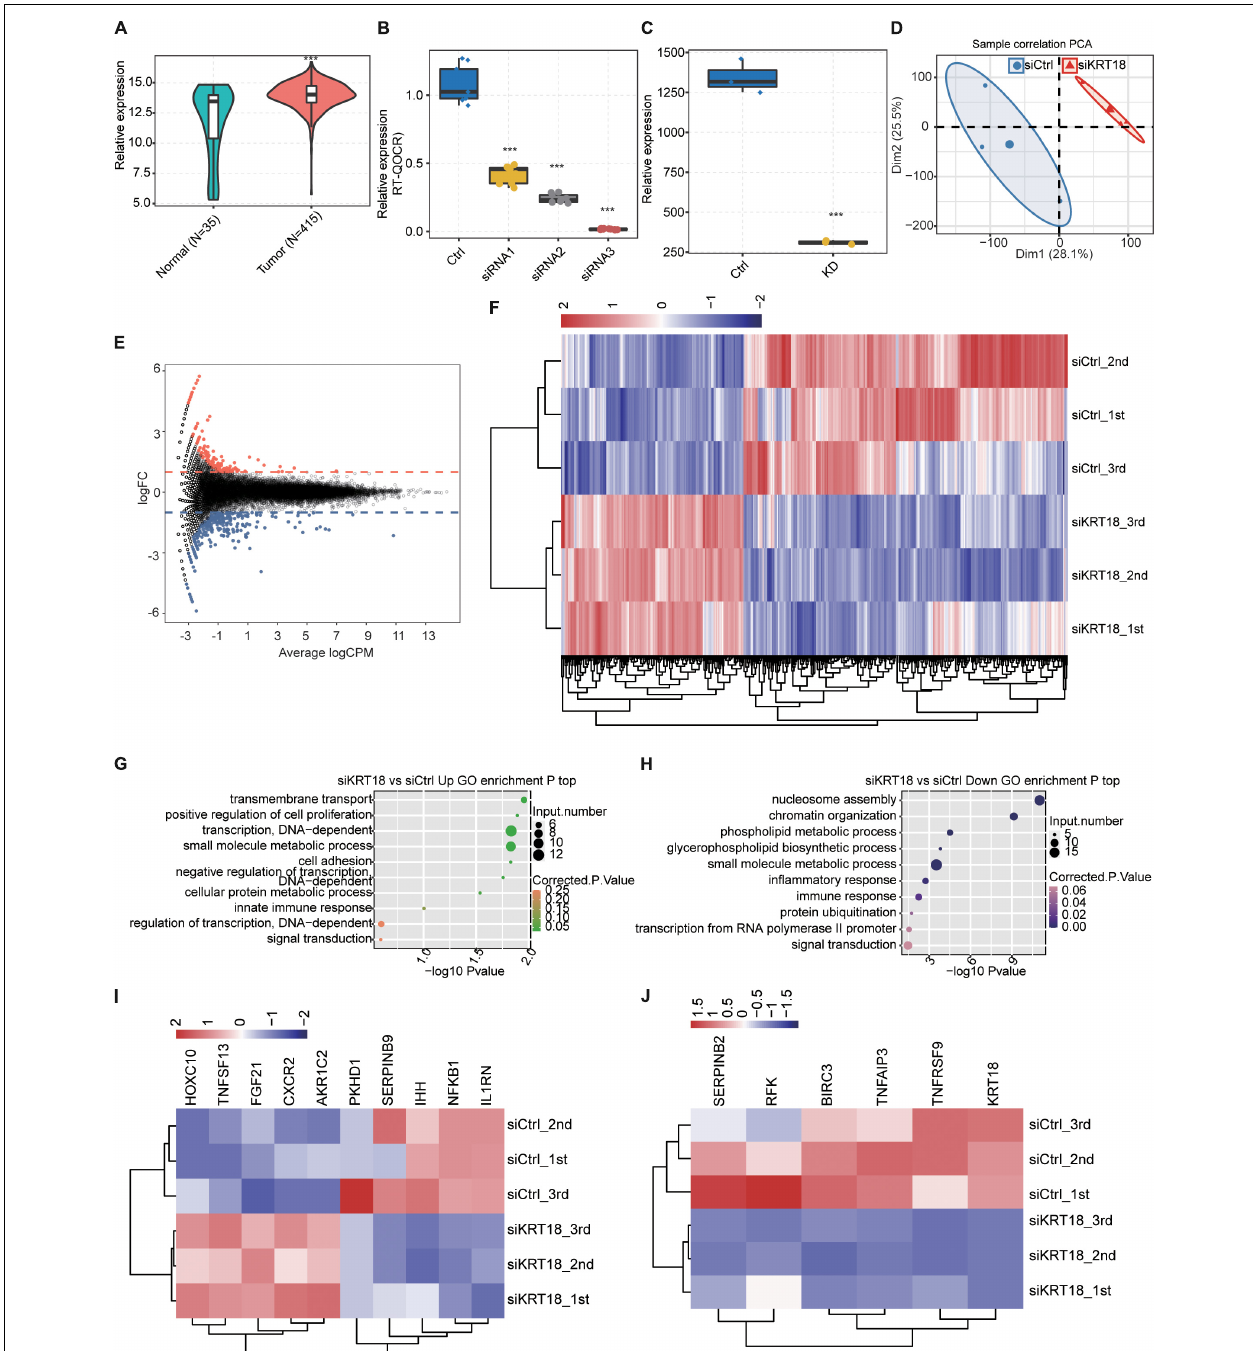
FIGURE 1 | Overexpression of KRT18 in stomach adenocarcinoma (STAD) and RNA-seq analysis of KRT18-regulated transcriptome profile in AGS cells. (A) Overexpression of KRT18 in 450 stomach adenocarcinoma (STAD) samples from TCGA database, including 415 tumor tissue and 35 normal samples (para-carcinoma tissue). (B) KRT18 expression quantified by qRT-PCR after knocking down KRT18 in AGS cells using three siRNAs. (C) KRT18 expression quantified by RNA sequencing data of AGS cells treated with KRT18 -siRNA2, FPKM values were calculated as explained in section “Materials and Methods.” Error bars represent mean ± SEM. *** p < 0.001, Student t -test. (D) Principal (F) (PCA) of KRT18 -KD versus control AGS cells based on FPKM value of all expressed genes. The samples were grouped by KRT18 -KD and control, and the ellipse for each group is the confidence ellipse. (E) MA plot shows KRT18-regulated genes identified in AGS cells. Up-regulated genes are labeled in red, whereas down-regulated genes are labeled in blue. (F) Hierarchical clustering of DEGs in KRT18 -KD and controls. FPKM values are log2-transformed and then median-centered by each gene. (G,H) The top 10 representative GO biological processes of up- and down-regulated genes. (I) Heatmap presenting deregulation expression of cell proliferation or apoptosis genes in KRT18 -KD AGS cells. (J) Heatmap presenting repressed expression of the other six apoptotic genes in KRT18 -KD AGS cells.